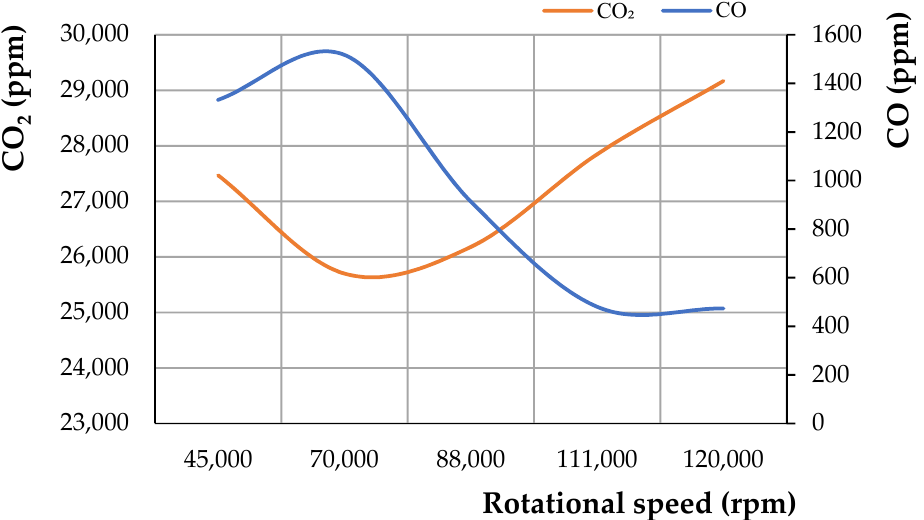
Figure 2. Relationship between CO and CO 2 concentrations in exhaust gases emitted by the miniature jet engine.